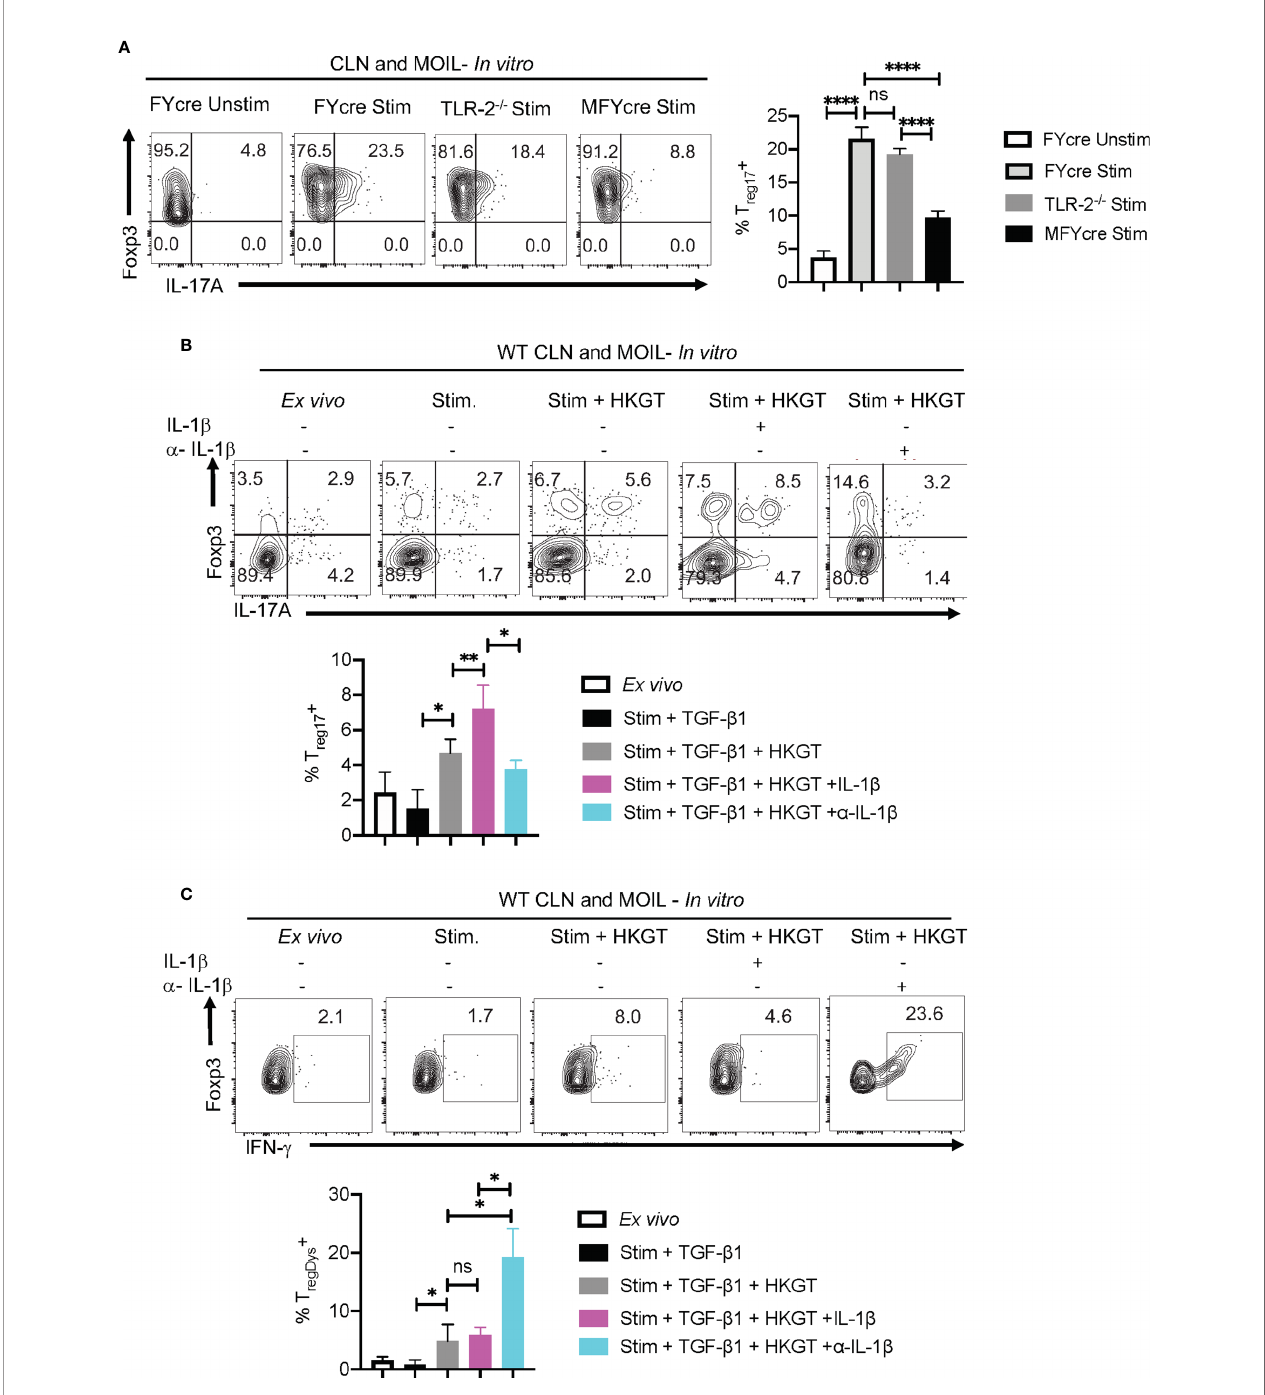
FIGURE 5 | IL-1 b promotes T reg 17 cells and constrains induction of T regDys cells in Candida activated oral mucosal cells in vitro . (A) HKGT mediated T reg 17 induction is slightly reduced in TLR-2 -/- T regs , but signi fi cantly lower in MFYcre T regs in vitro . Pooled cervical lymph nodes (CLN) and mouse oral intra-epithelial and lamina propria leukocytes (MOIL) cells from FYcre and MFYcre were stimulated with heat killed Candida albicans germ tube (HKGT) as in Figure 1C for 5 days and were restimulated with PMA-Ionomycin for fl ow cytometry assessment. For TLR-2 -/- cultures, T regs were puri fi ed from TLR-2 -/- mice and stimulated with WT APC from T cell depleted CLN and MOIL cells. Flow cytometry plots showing Foxp3 and IL-17A expression (gated on CD3 + CD4 + Foxp3 + cells). (B, C) WT CLN and MOIL cells were examined ex vivo or stimulated with HKGT as in Figure 1C , in the presence of IL-1 b (10 ng/ml) or a - IL- b antibody (10 m g/ml) for 5 days. Flow cytometry plots showing Foxp3 and IL-17A expression (gated on CD3 + CD4 + cells) ( B , top) and statistical data points from experimental replicates ( B , bottom). Flow plots showing Foxp3 and IFN- g expression (gated on CD3 + CD4 + Foxp3 + cells) (C) and statistical data points from experimental replicates ( C , bottom). NS, non-signi fi cant. *P < 0.005, **P < 0.0005, ****P <